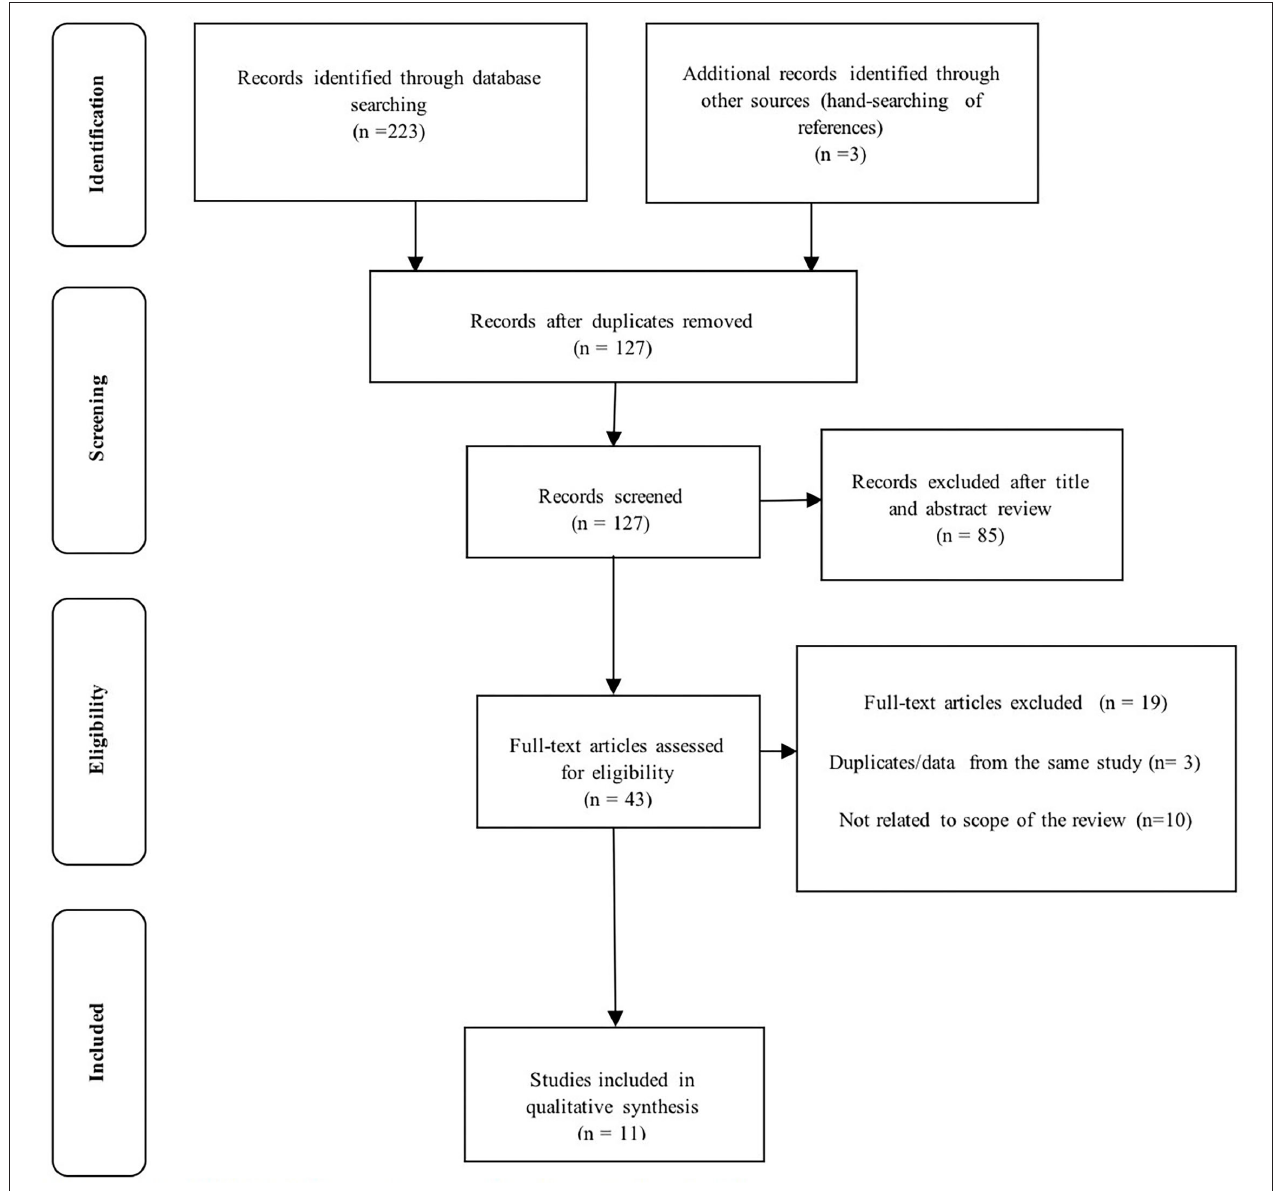
FIGURE 2 | The PRISMA flow diagram for the study selection